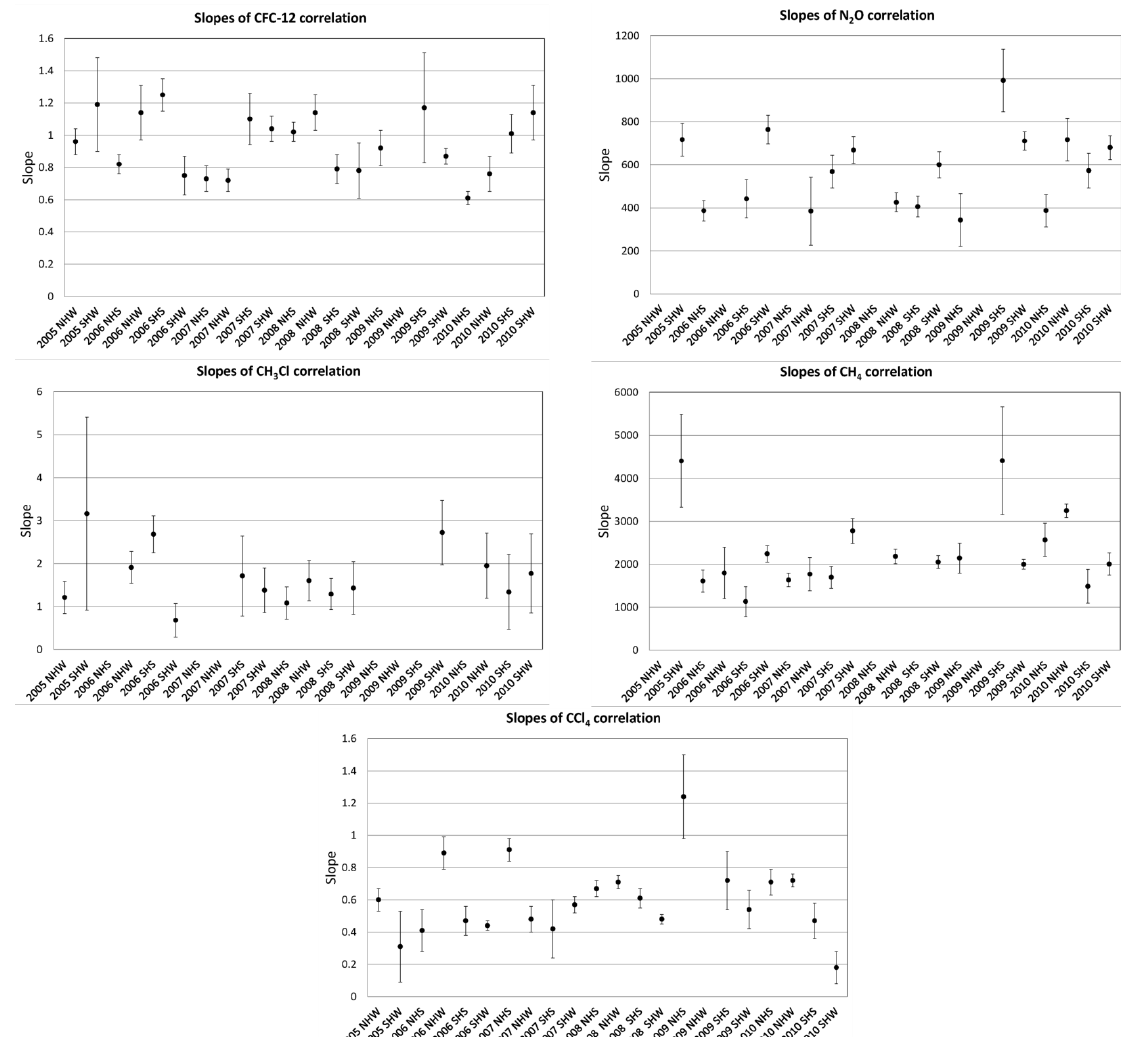
Fig. A1. A graphical representation of the slopes of the various correlations with CFC-11. The data is presented in the same order as it appears in Table 1 above